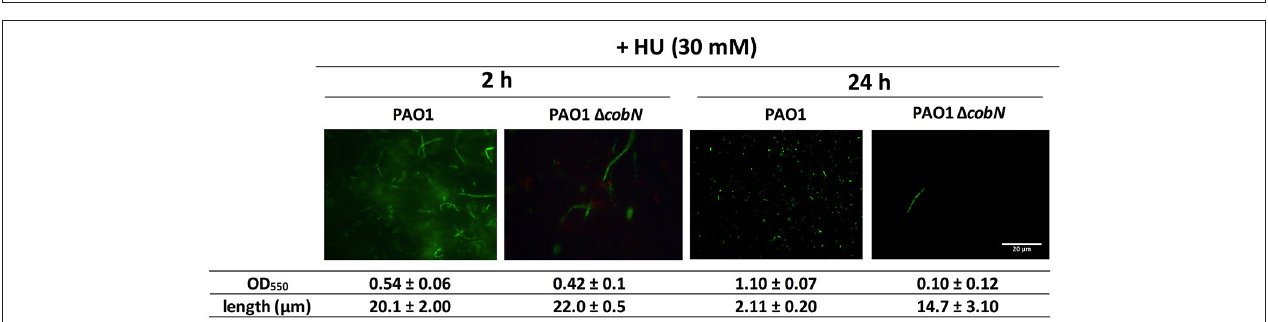
Frontiers in Microbiology | www.frontiersin.org